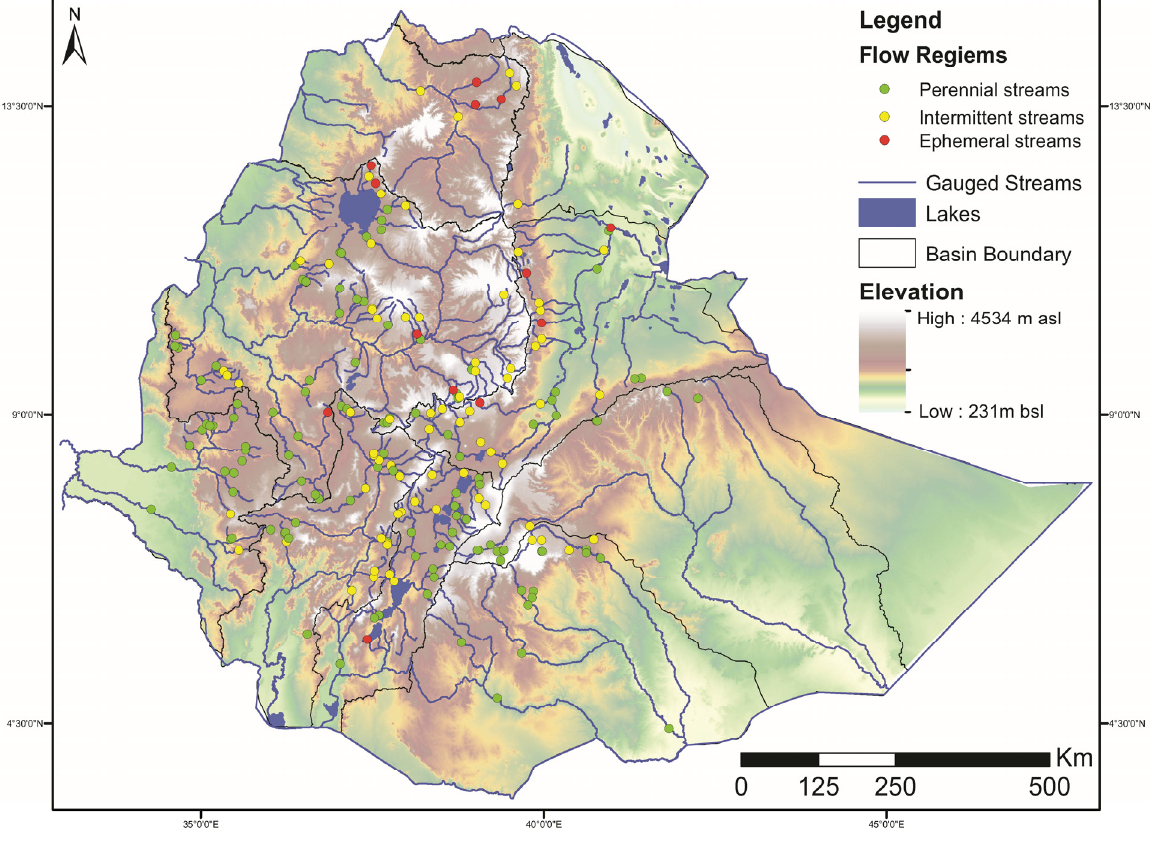
Figure 5. Flow regimes of Ethiopian streams along with elevation